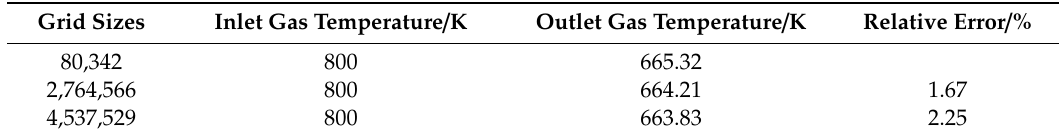
Table 2. Grid independence verification.